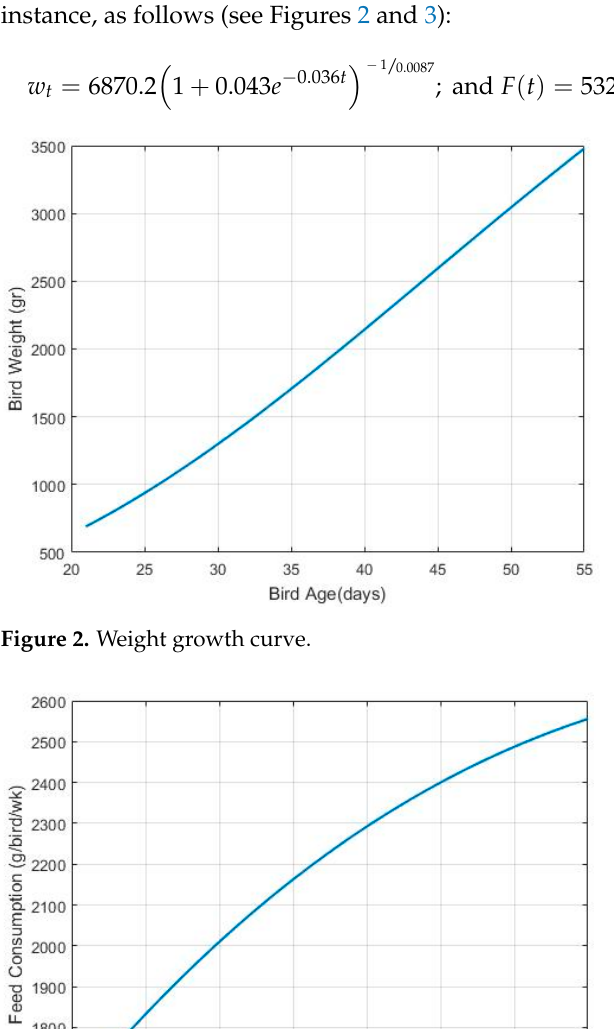
Figure 4. Cumulative daily mortality curve.